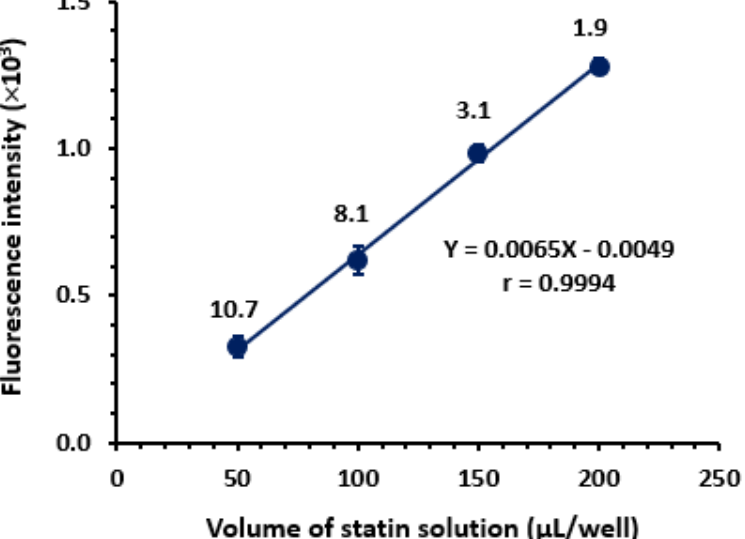
Figure 6. Effect of volume of PIT solution (1 µg mL –1 ) on the fluorescence intensity measured by the fluorescence microwell reader. The linear fitting equation of fluorescence intensity (Y-axis) vs. volume (X-axis) and its correlation coefficient (r) is given on the graph. The values are the mean of 3 determinations ± SD and the figure given on each point is the relative standard deviation of the readings.